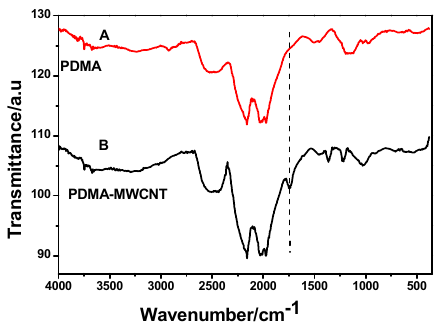
Figure 2. Fourier transform infrared (FTIR) spectra of ( A ) PDMA and ( B ) PDMA-MWCNT.